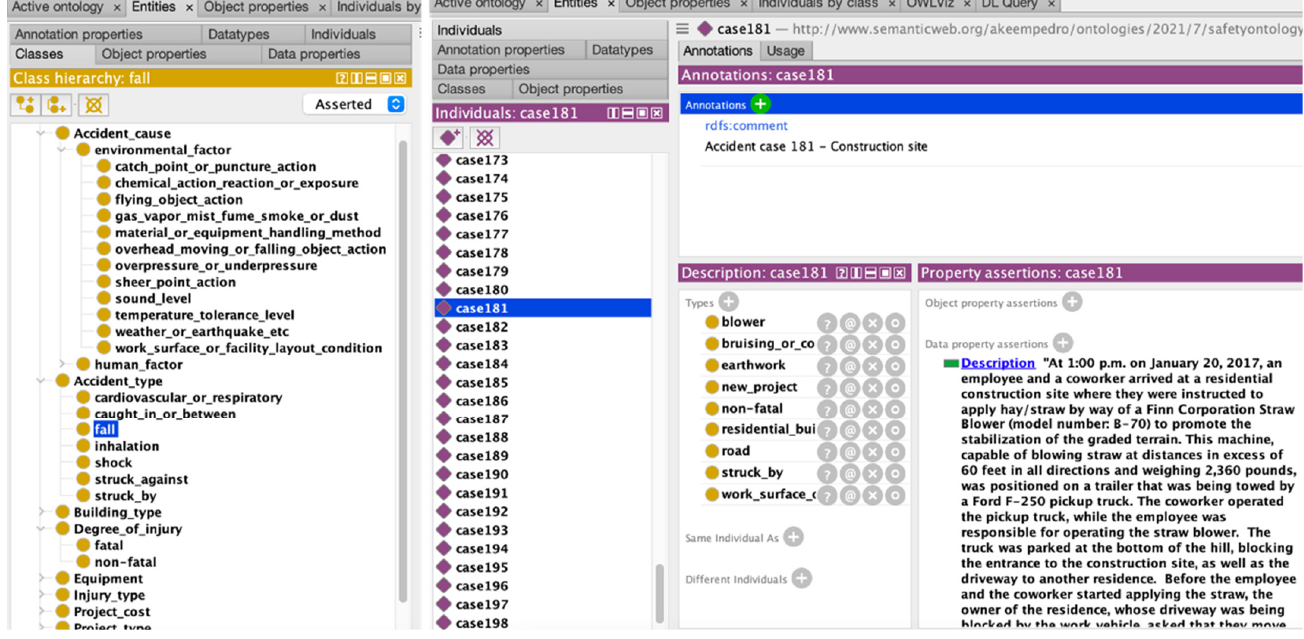
Figure 5. Ontology for construction safety information sharing.